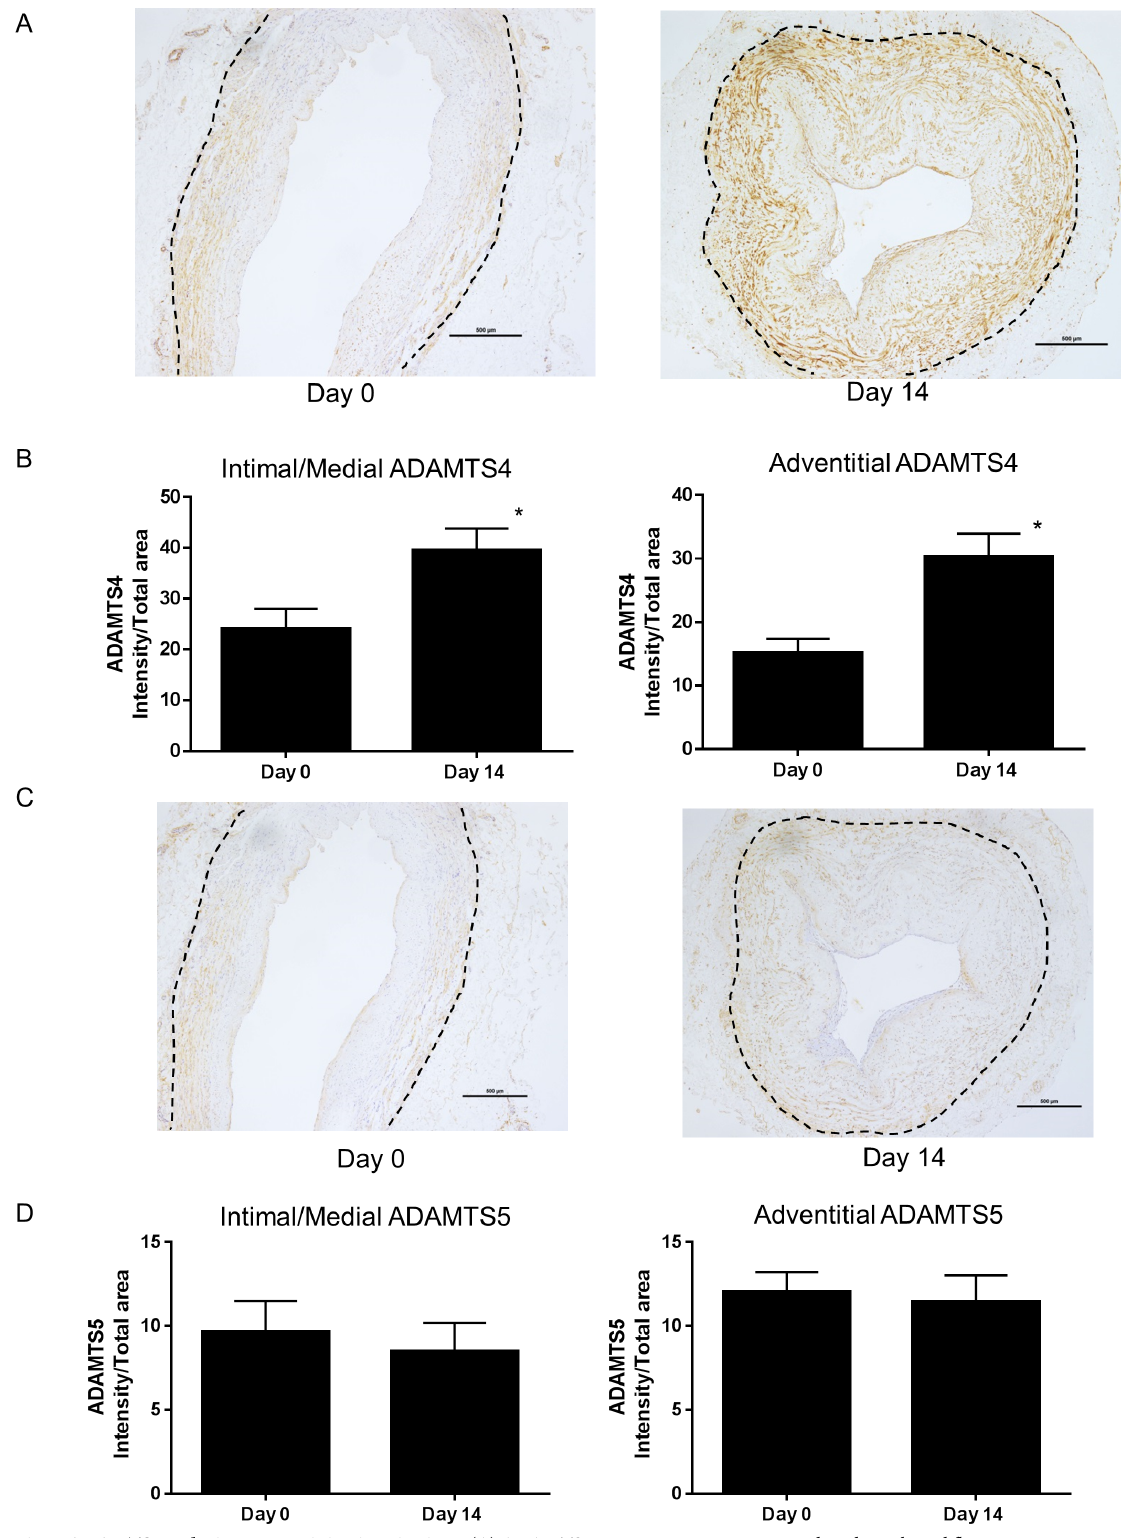
Fig 2. ADAMTS4 and 5 immunostaining in vein rings. (A) ADAMTS4 immunostaining in pre- and 14 day cultured floating vein rings was quantified (B) for the intima/media and adventitia ( (cid:3) P < 0.0001 day 0 vs day 14; N = 20 veins). (C) ADAMTS5 immunostaining in